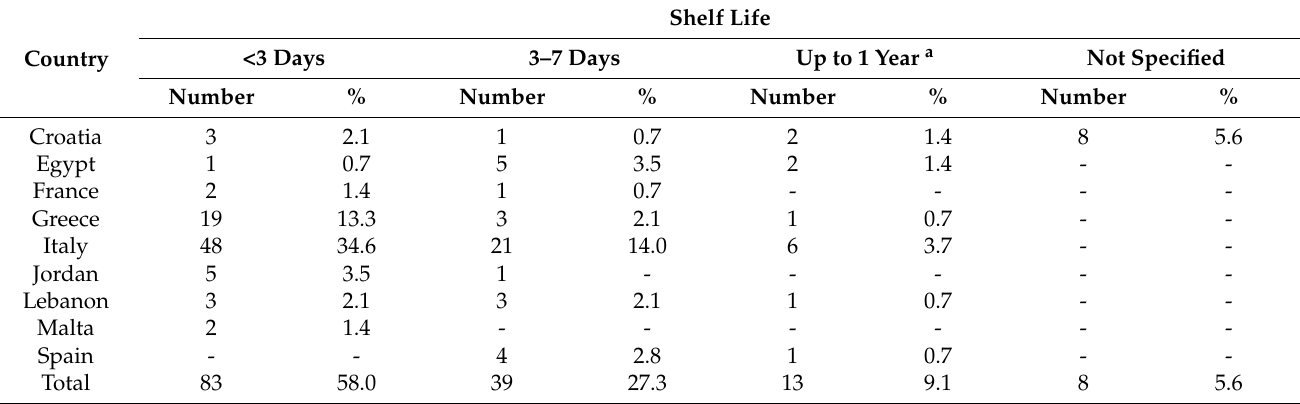
Table 10. Shelf life of flat